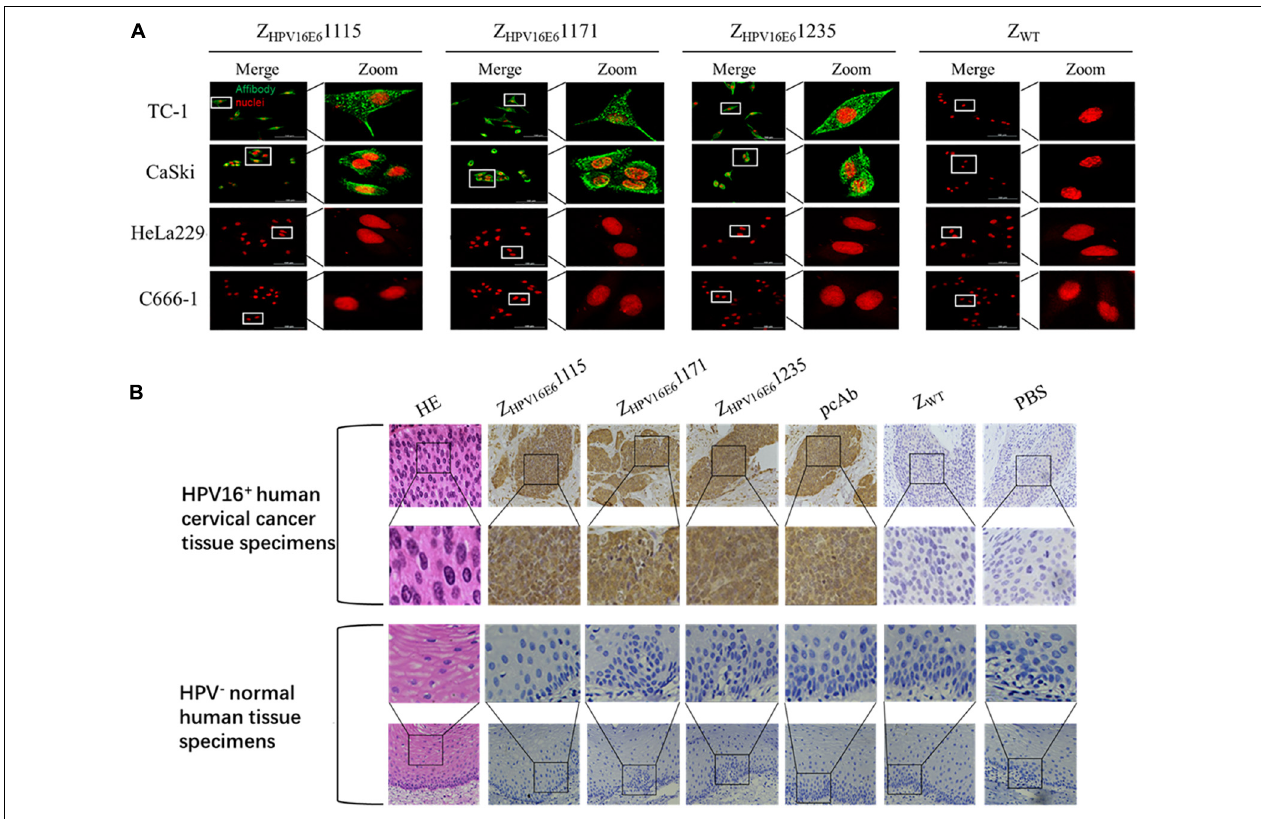
FIGURE 3 | Immunofluorescence and immunohistochemical staining analyses of the binding specificity of Z HPV16E6 affibodies to HPV16 E6. (A) Representative images showing TC-1, CaSki cells (HPV16 positive), HeLa229 (HPV18 positive), and C666-1 cells (HPV negative) stained with Z HPV16E6 1115, Z HPV16E6 1171, and Z HPV16E6 1235. The Z WT affibody was used as a negative control. The affibody molecule stain is shown in green, while the nuclear stain (PI) is shown in red; magnification at × 400. (B) Representative image of HPV16-positive cervical cancer sections and HPV-negative normal human sections by hematoxylin and eosin (HE) staining and immunohistochemistry (IHC) staining with Z HPV16E6 affibodies. Sections from HPV16-positive cervical cancer sections (upper panel) and HPV-negative normal human sections (lower panel) were labeled with Z HPV16E6 affibodies. Polyclonal HPV16 E6 antibody was used as a positive control. Z WT and PBS were used as negative controls. Magnification at ×